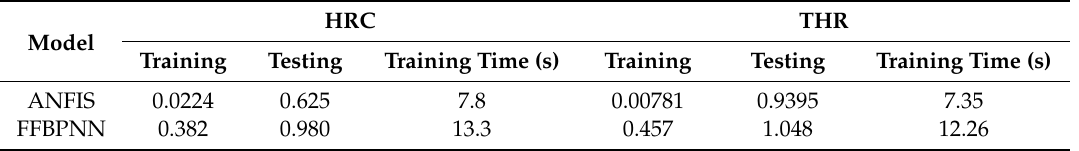
Table 9. Error comparison from ANFIS and Feed Forward Back Propagation Neural Network models. Model